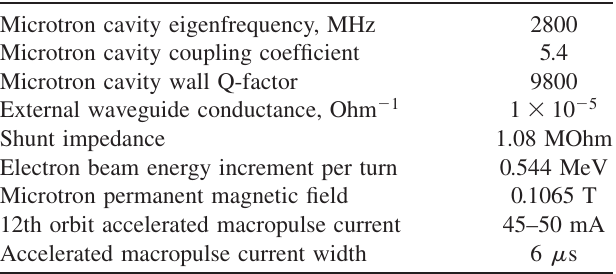
TABLE II. Main parameters of the